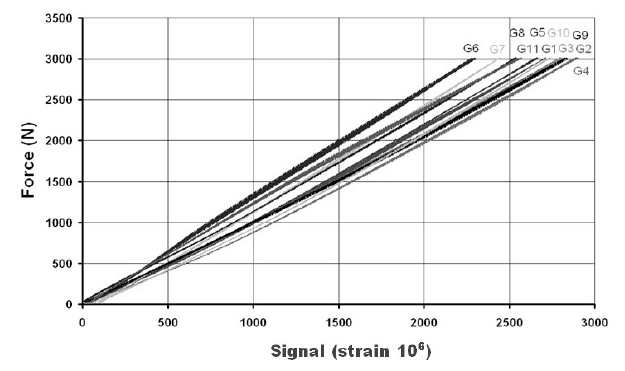
Fig. 4. Force/signal curves of the sensors of the left